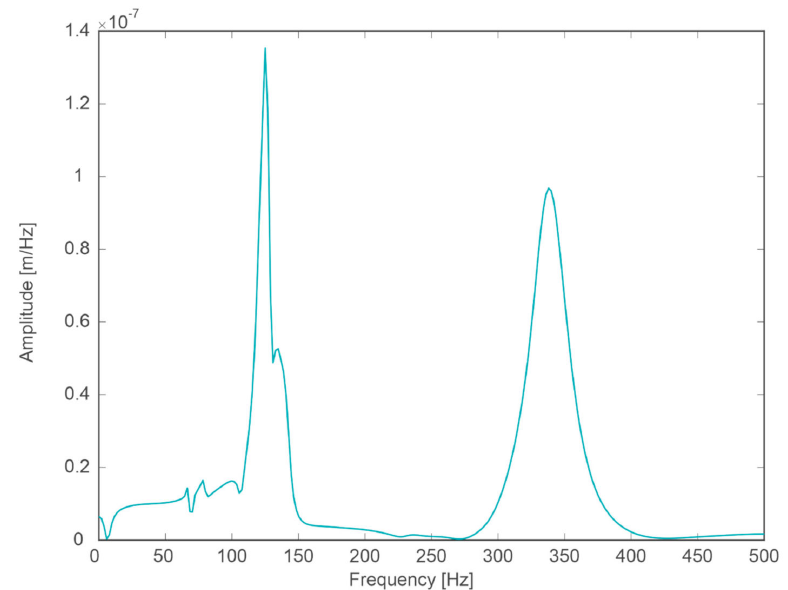
Figure 18. Spectrum generated from lateral displacement in the direction z of the capsule at a speed of 1000 km / h.